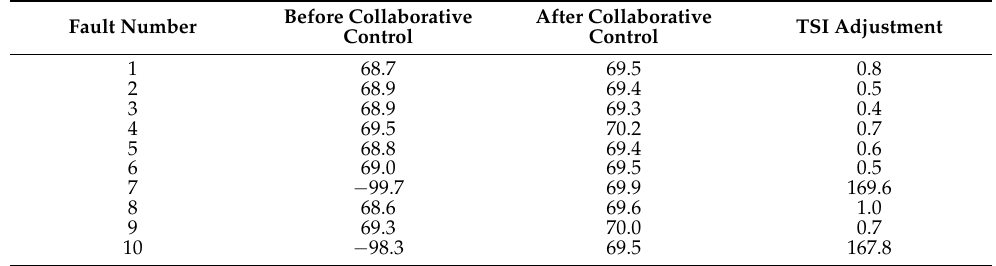
Table 7. Comparison of TSI before and after collaborative transient stability control of IEEE 39 bus system.